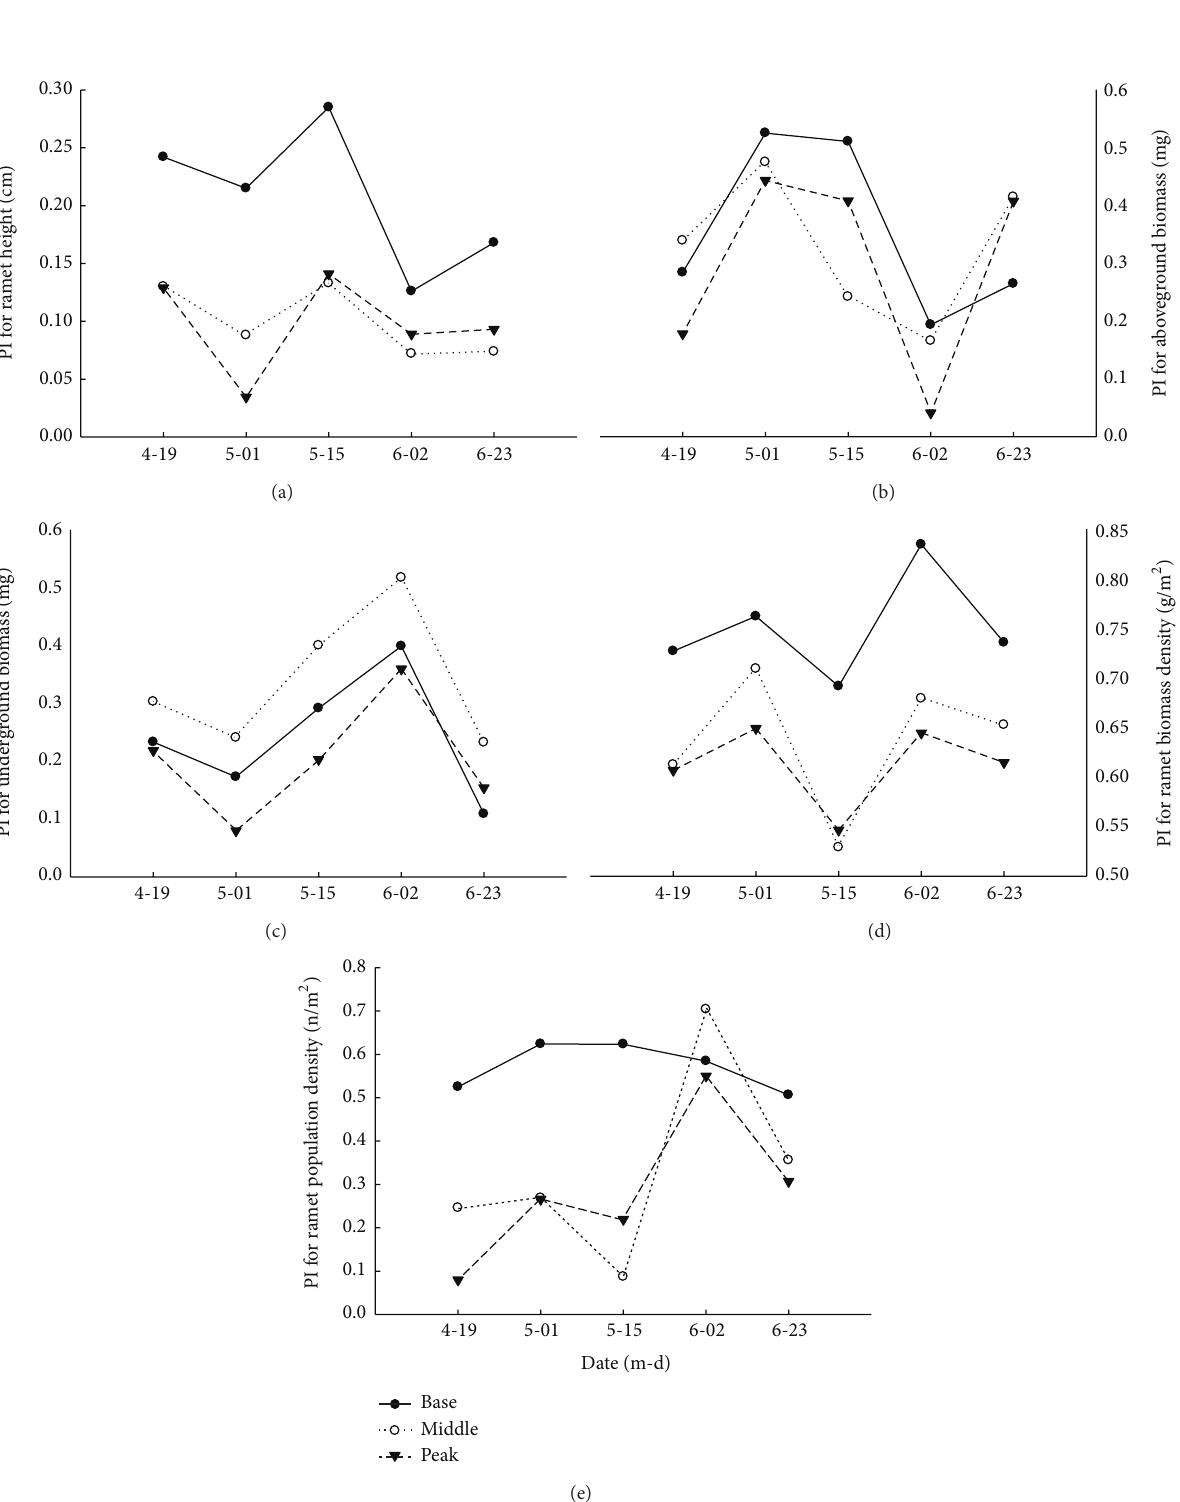
Figure 5: Plasticity index (PI) for ramet height, aboveground biomass, underground biomass, ramet biomass density, and ramet population density of Carex physodes on different sampling dates and locations of the sand